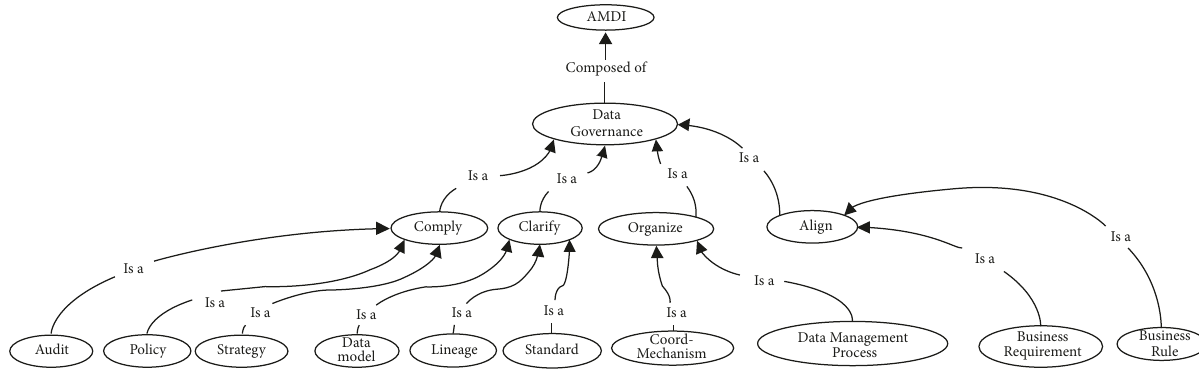
Figure 6: The data governance class model.